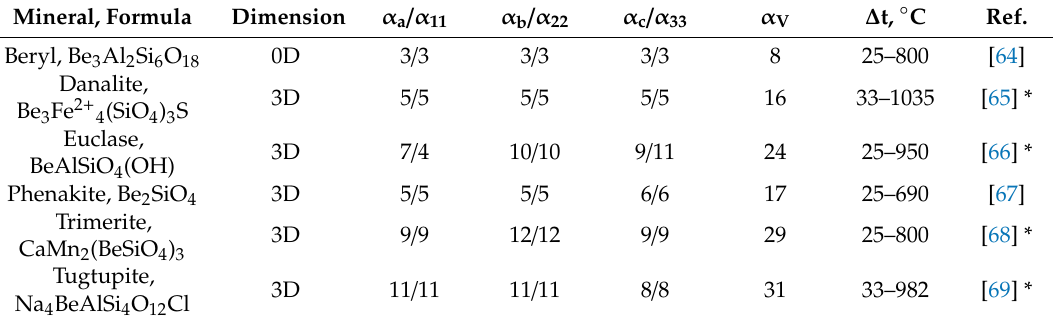
Table 5. TECs ( × 10 6 ◦ C − 1 ) of beryllium silicate minerals along the principal axes of the thermal expansion tensor and along the crystallographic